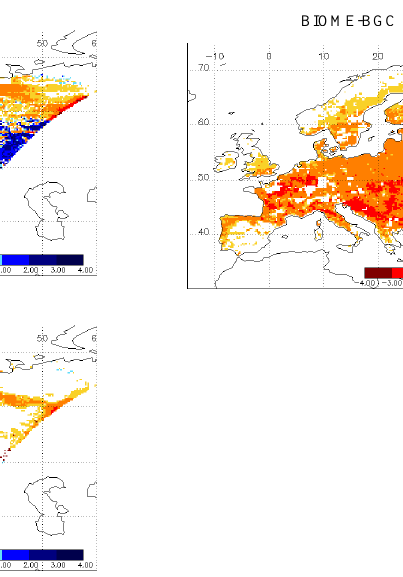
Fig. 5. Cumulative net land-atmosphere fluxes (kgC per 50 years, sum over 1951–2000) estimated with three ecosystem models. NBP for JULES and ORCHIDEE refer to a simulation accounting for climatic changes, increases in atmospheric CO 2 concentrations, and land use changes (Clim+CO 2 +LUC). The NEE simulated by BIOME-BGC is driven by climatic changes, increases in CO 2 and atmospheric nitrogen deposition (Clim+CO 2 +N). Areas colored in different shades of red and yellow are carbon sink. Areas colored in different shades of blue are carbon